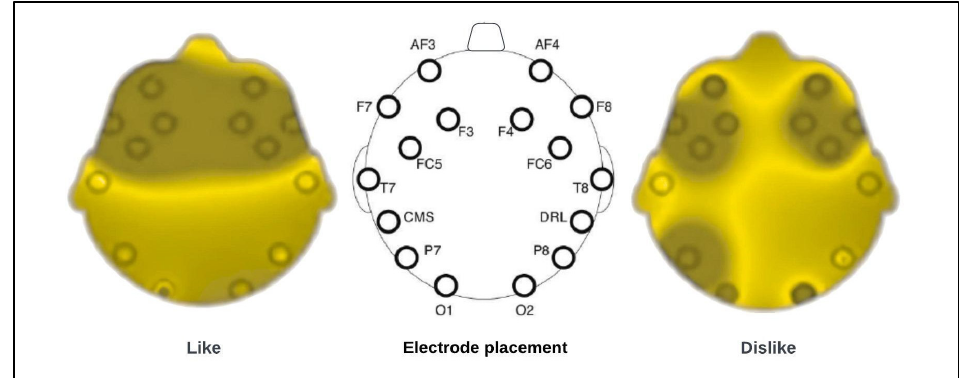
Figure 2. The correlation between EEG and decision-making of subjects.